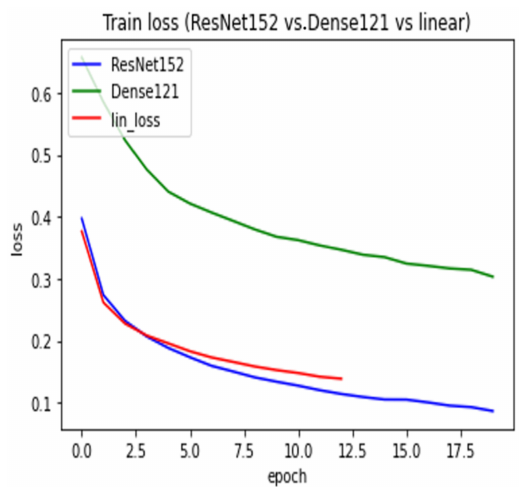
Figure 19. Validation Accuracy curves for ResNet152, Dense121, and linear models.